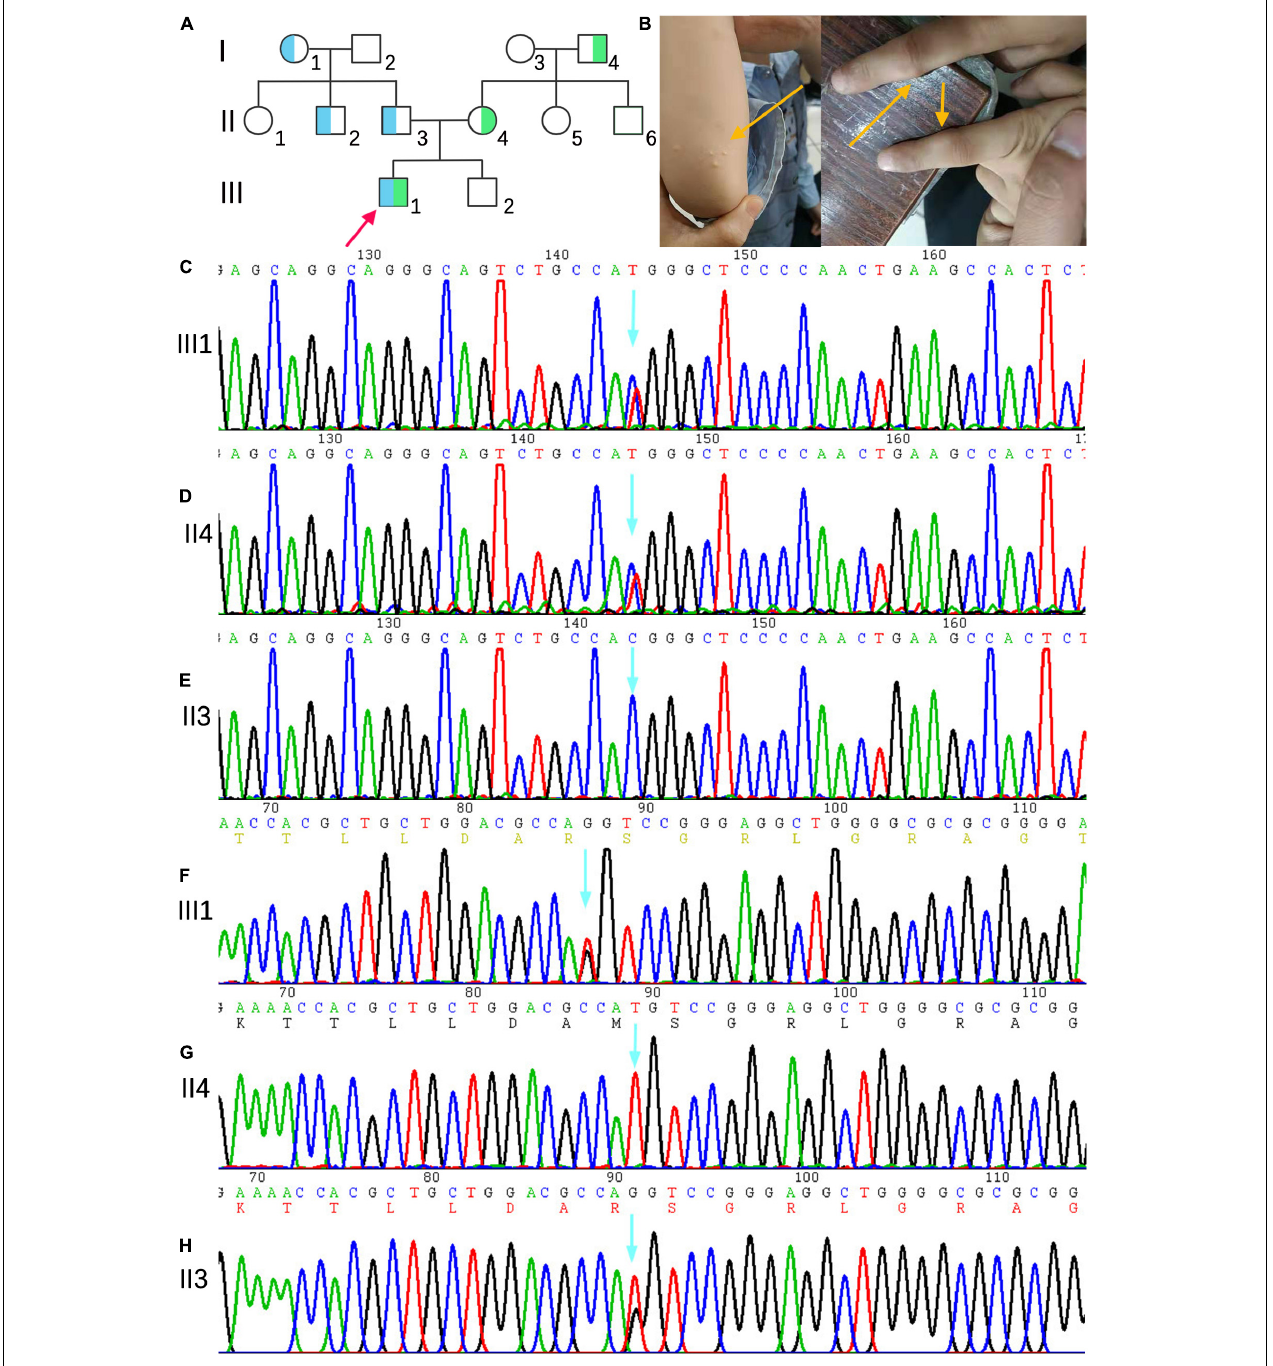
FIGURE 1 | (A) Family genetic pedigrees map for sitosterolemia. Blue indicates a carrier of the mutation of ABCG5 (NM_022436) c.296 T > G (p.M99R) and green indicates a carrier of the mutation of ABCG5 c.-76 C > T. the arrow indicates the proband, the square indicates males, and circle indicates female. (B) The proband’s joint skin xanthoma. (D–E) Sanger sequencing showed that proband III1 carried the c.-76 C > T heterozygous variant inherited from mother (II4). (F–H) Sanger sequencing map showing that proband III1 carried the c.296T > G (p.M99R) heterozygous variant inherited from father (II3).